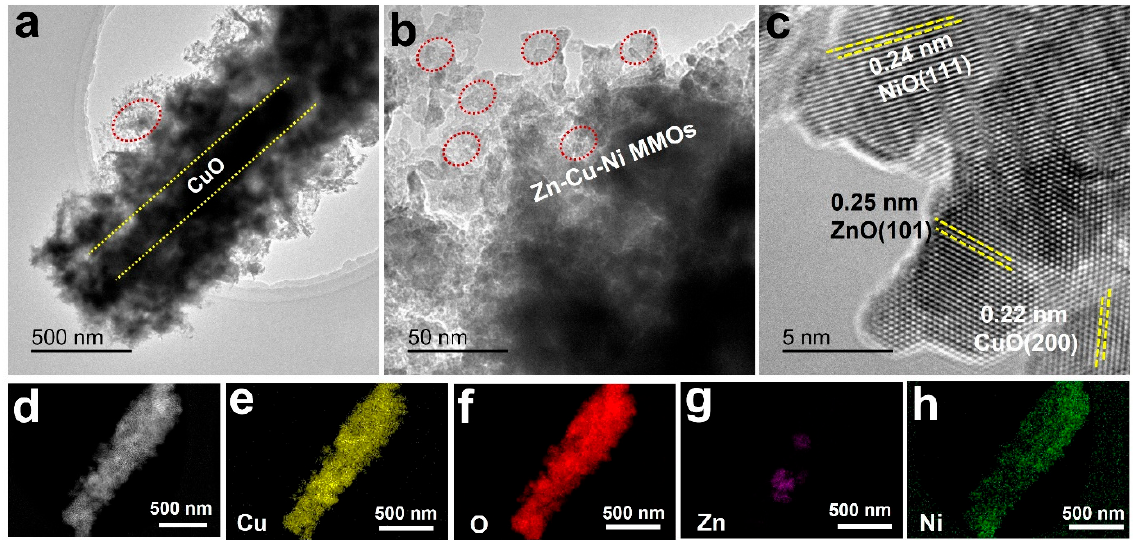
Figure 3. TEM ( a , b ), HRTEM ( c ), dark-field TEM ( d ), and elemental mapping ( e – h ) images of the ZnCuNiO x MMOs.